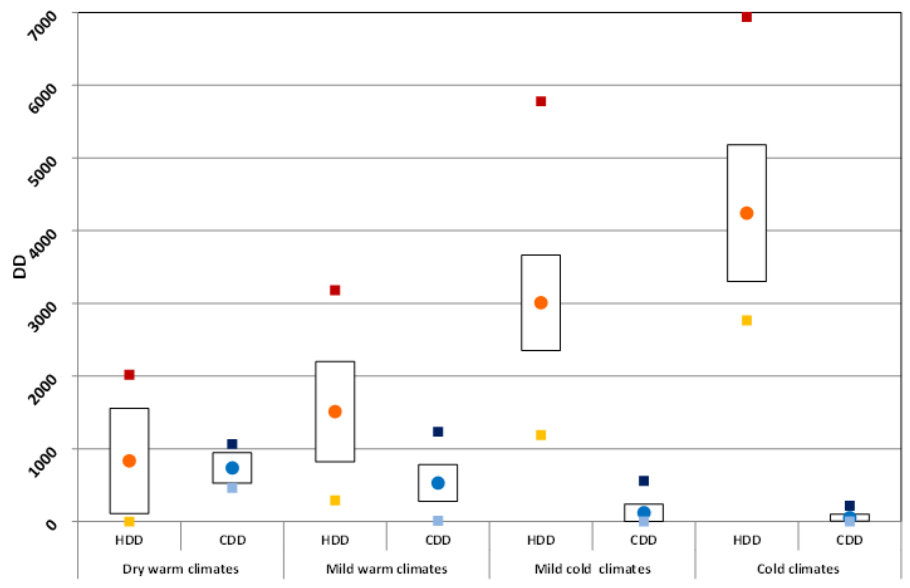
Figure 7. Average values (circles), standard deviation (bars), minimum and maximum values (squares) for the HDD (red, yellow and orange) and for the CDD (blue, light and dark blue) for the macro-groups of climate classes in Europe.